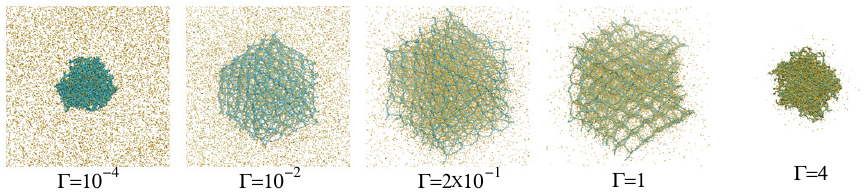
Figure 1. Snapshots of gel particles (blue) with N c = 729 crosslinks in the presence of counterions (yellow) for various Coulomb interactions strengths Γ as